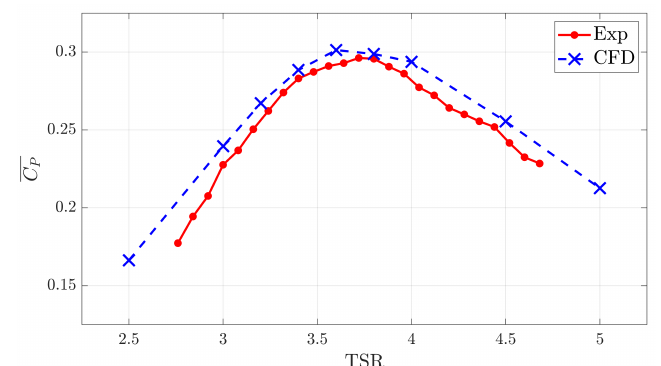
Figure 5. Vertical profile of normalized incoming velocity and turbulence intensities.